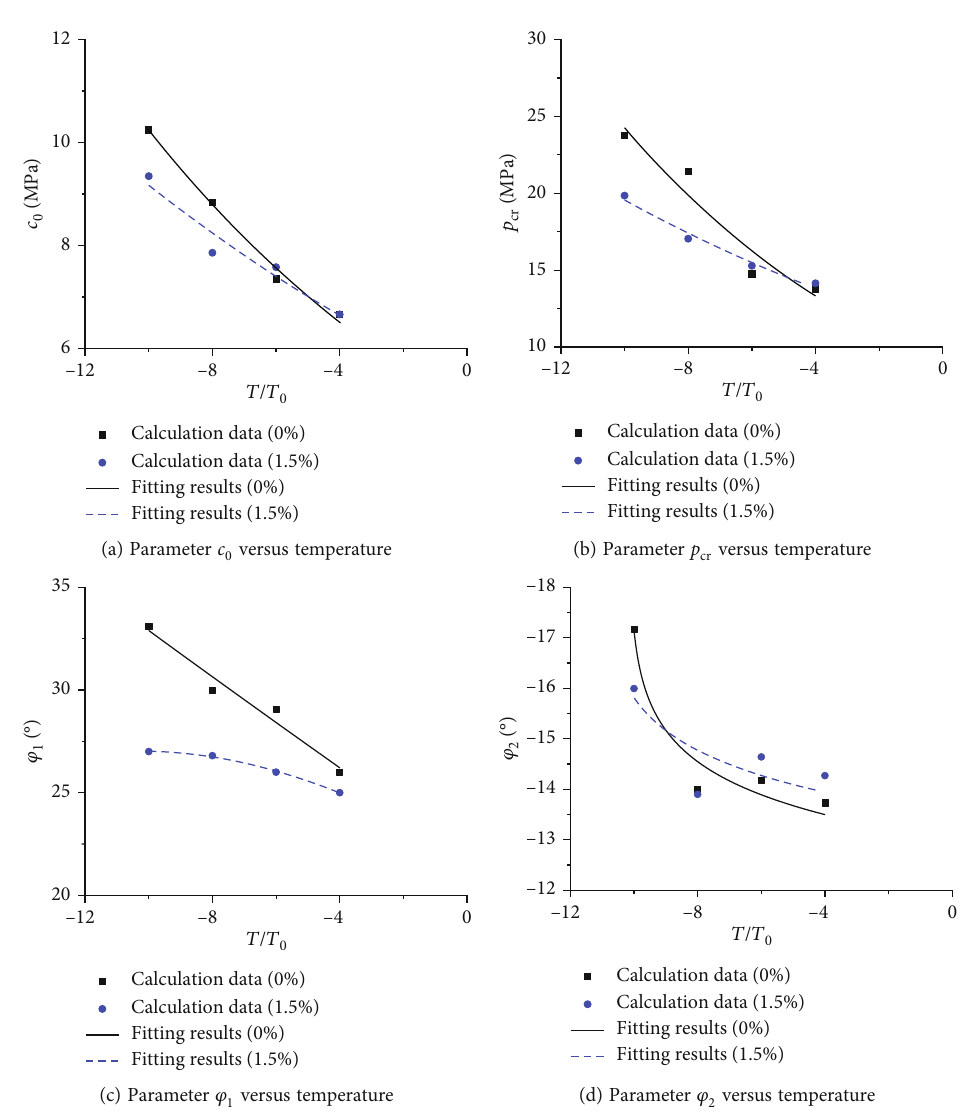
Figure 4: Relationships between model parameters and temperature. Table 2: Fitting parameters obtained from the test